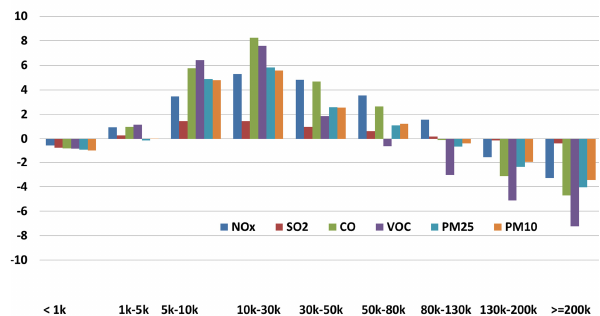
Figure 12. MFD (%) of 2050 annual emissions, Future minus Fu- ture05Surr , stratified by 2050 grid-cell population. ( Future : 2050 inventory, 2050 surrogates, county growth factors; Future05Surr : 2050 inventory, 2005 surrogates, county growth